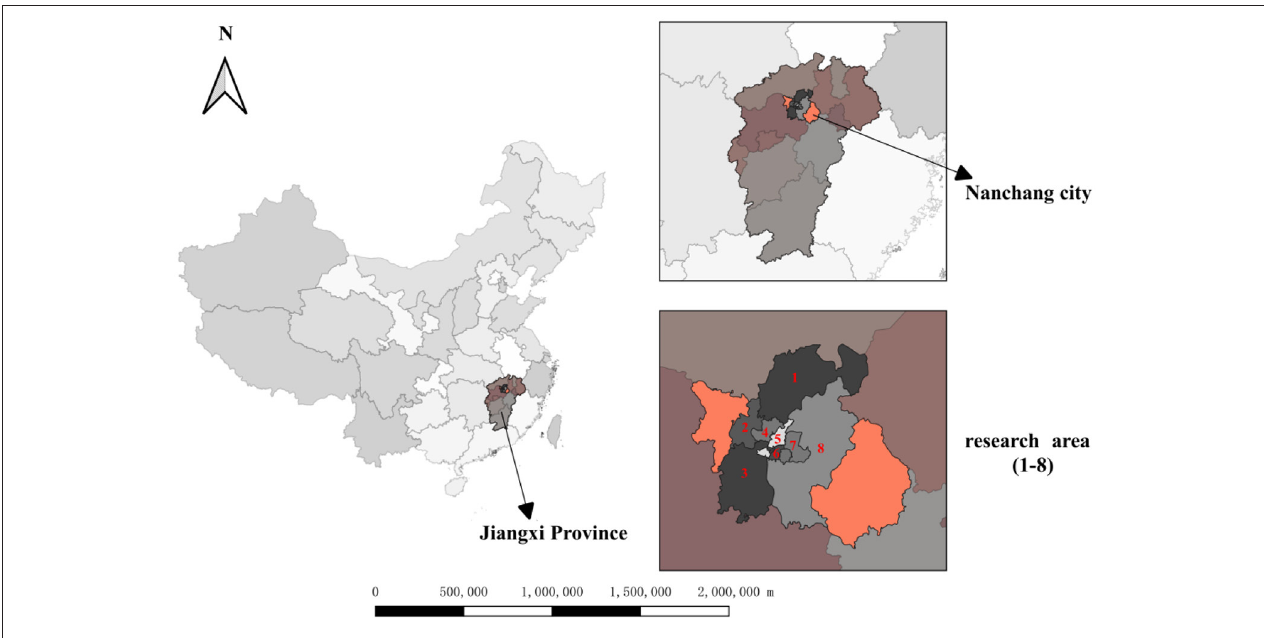
FIGURE 1 | Ozone monitoring sites in Nanchang city, Jiangxi province, 2014–2020.